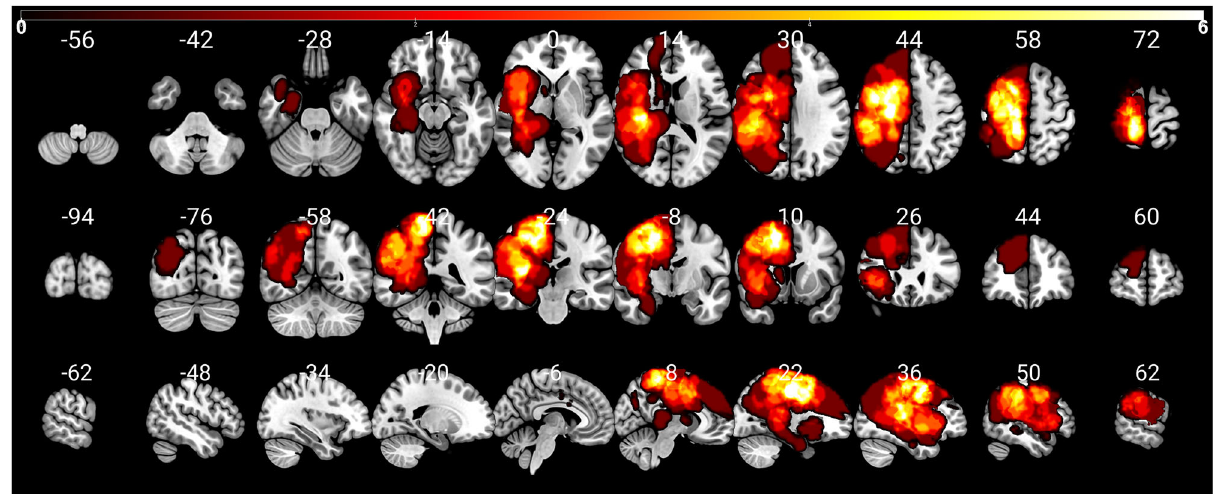
Fig. 5 Distribution of the patients ’ lesions. The color bar indicates the occurrence of lesions per voxel (white = high quantity, 0 – 6). To enable a clear comparison of lesion location, lesions of the left hemisphere were mapped to the right hemisphere. The numbers on top of the slices show their position in MNI